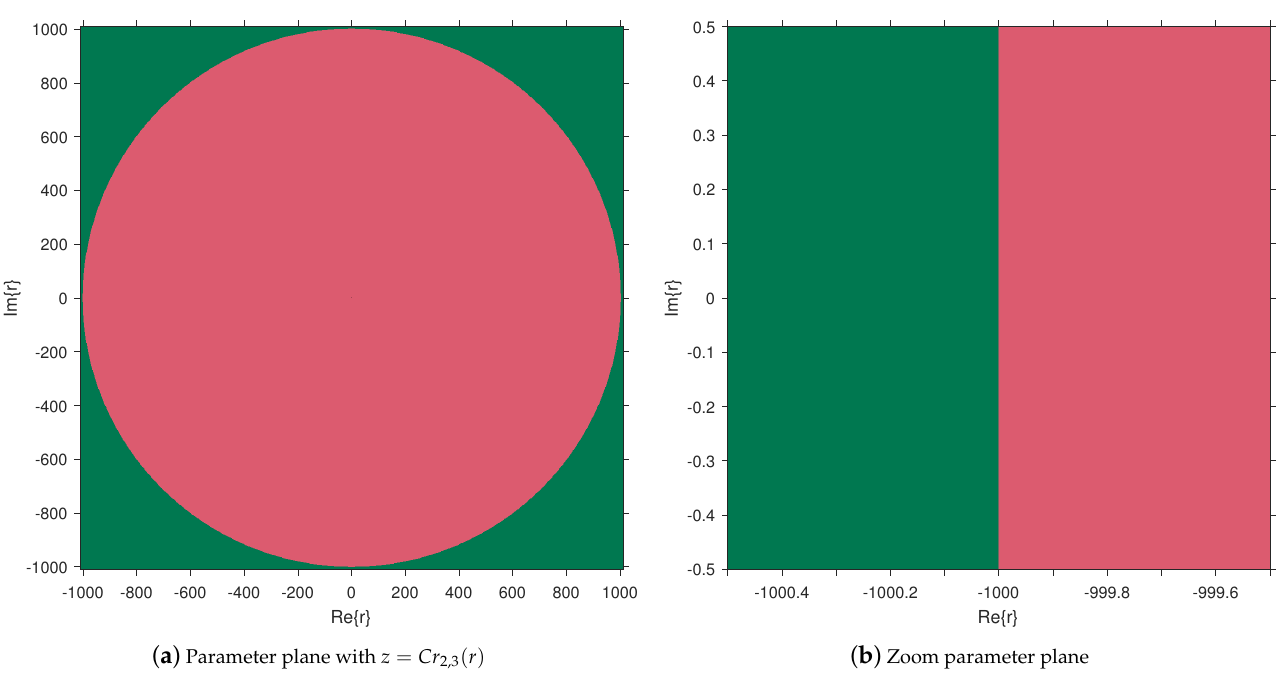
Figure 5. P 1 for Cr 2,3